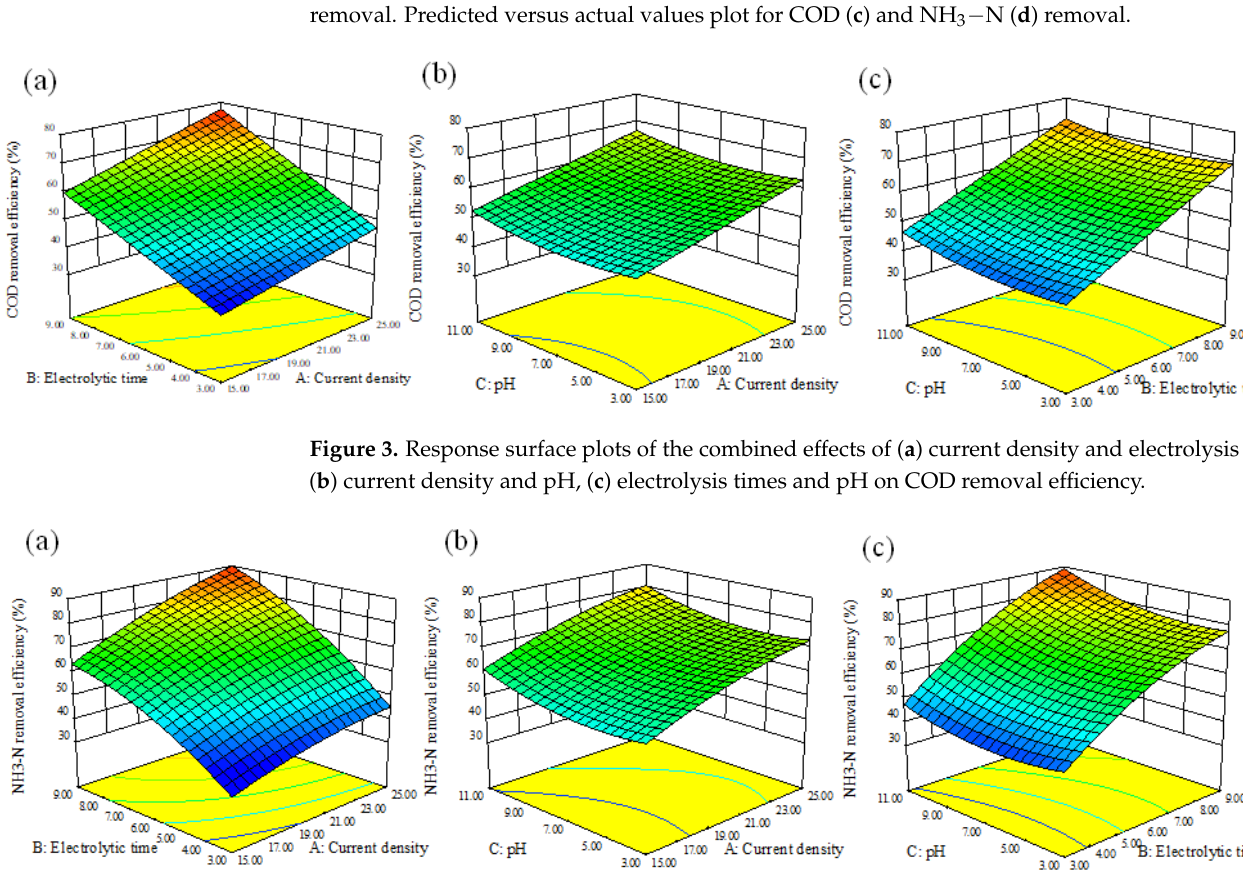
Figure 4. Response surface plots of the combined effects of ( a ) current density and electrolysis time, ( b ) current density and pH, ( c ) electrolysis times and pH on NH 3 -N removal efficiency.